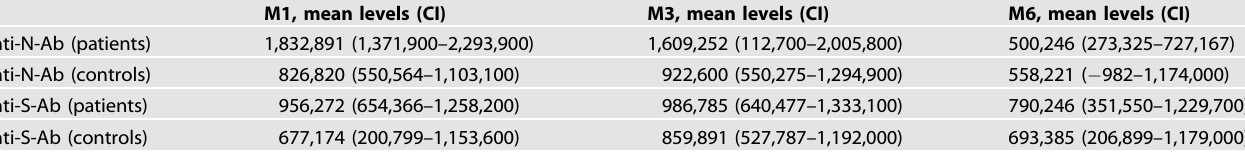
Table 2. Mean levels (LU) of anti-N and anti-S-Ab in patients and controls (all samples). M1, mean levels (CI) M3, mean levels (CI) M6, mean levels (CI)